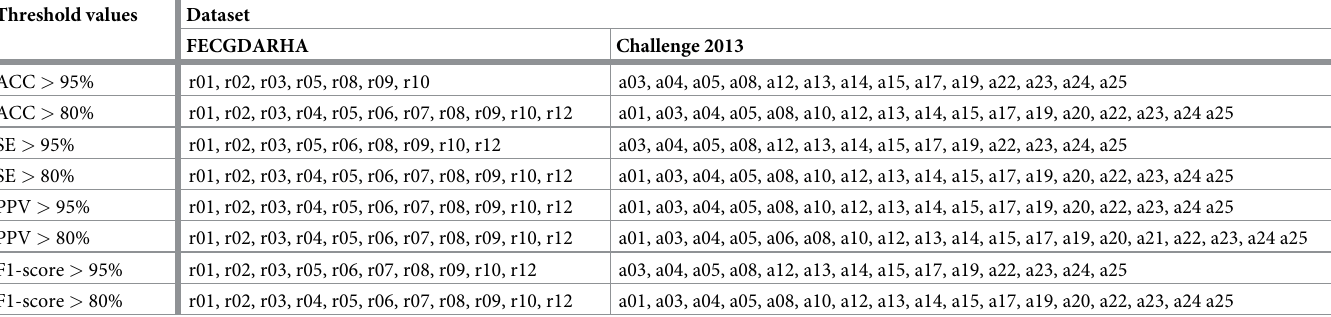
Table 3. Summary of records from both databases, which reached threshold values (80% and 95%). Threshold